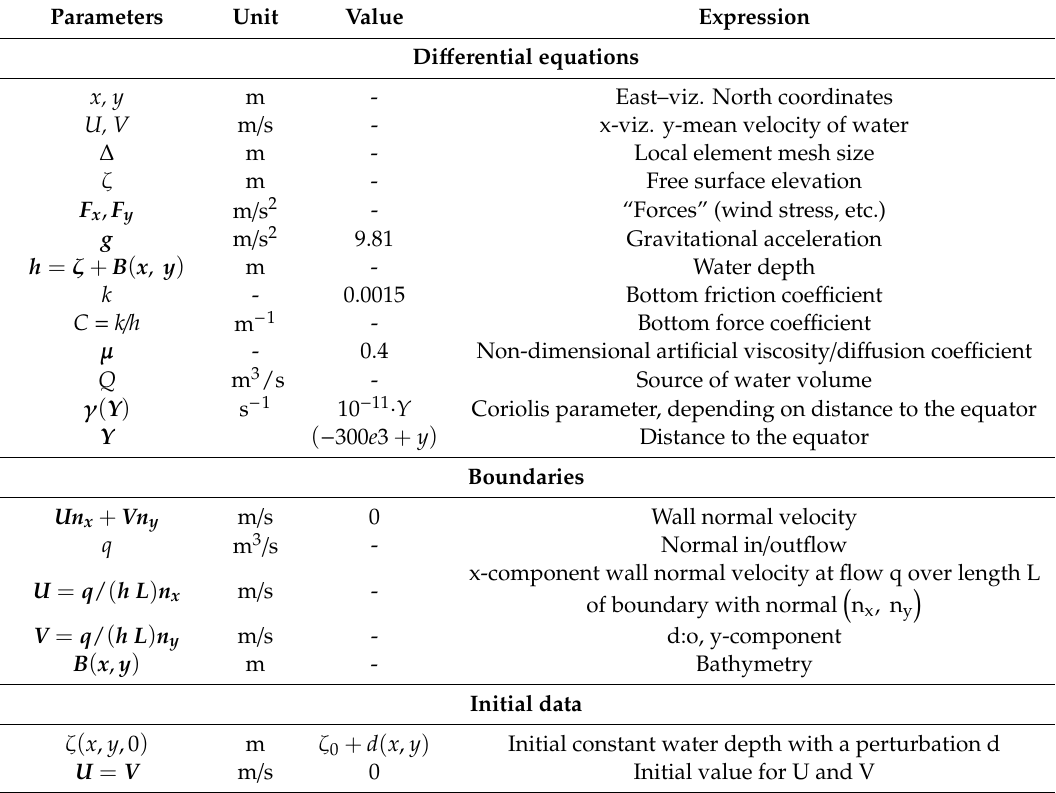
Table 1. Description of SWE